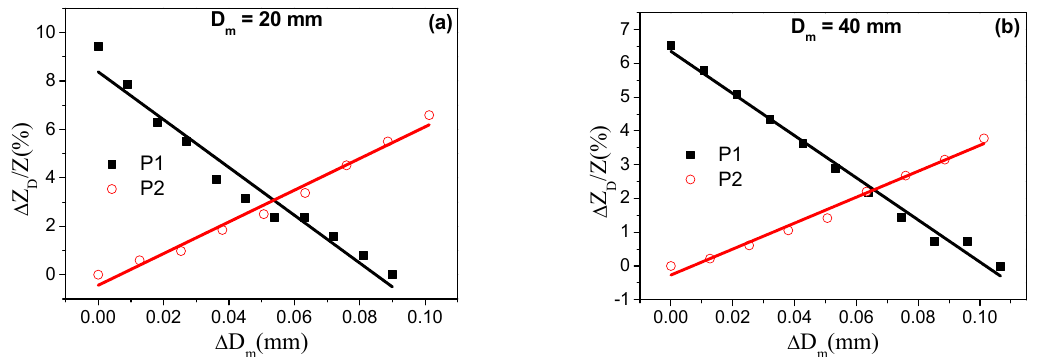
∆ Z ( % ) , as a function of the induced variations in probe D Z ∆(cid:3027) (cid:3253) (%) , as a function of the induced variations (cid:3027)